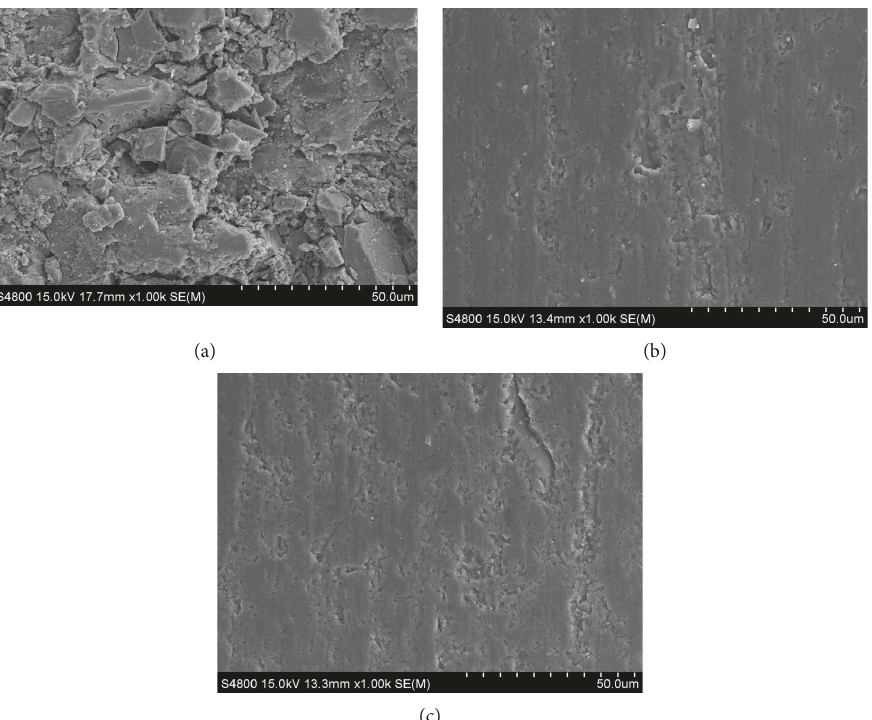
Figure 9: Micromorphology of the limestone surface: (a) before the polishing process; (b) after 20 × 10 4 polishing cycles; (c) after 28 × 10 4 polishing cycles.